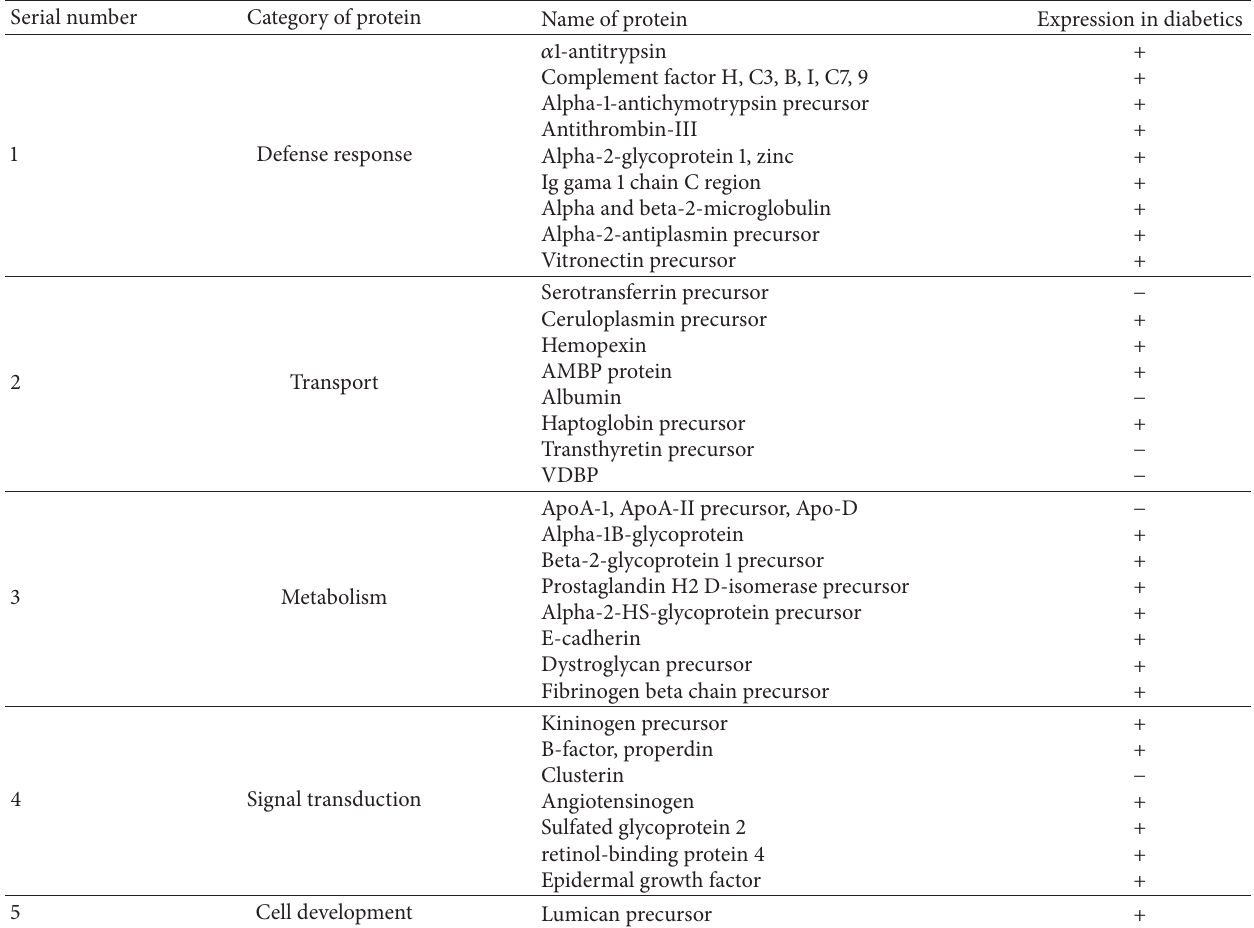
Table 2: Urinary protein identified in diabetes